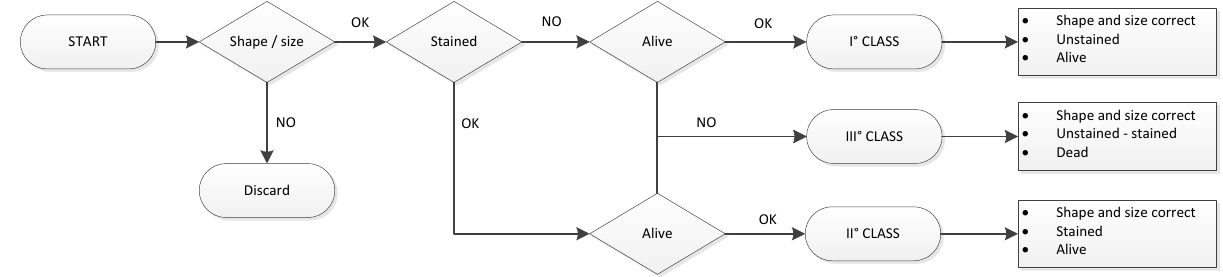
Figure 2. Flow chart of the sorting and selection steps of the sorting machine.